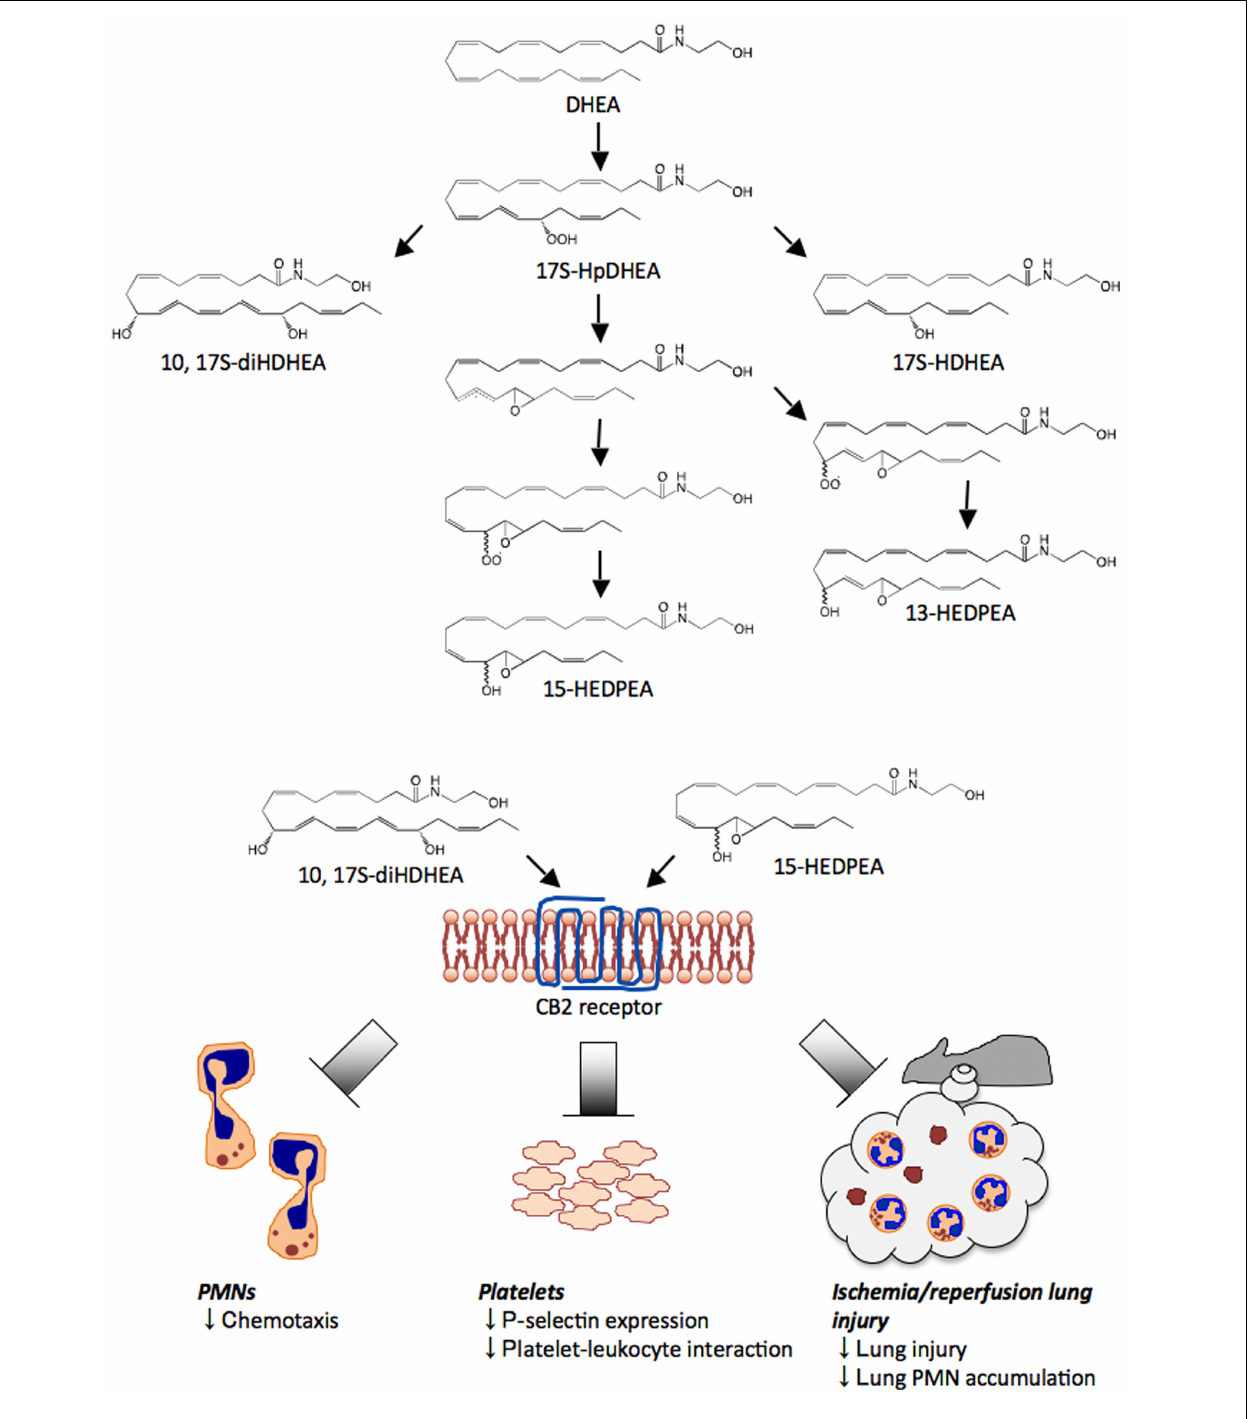
mechanism, 17-HpDHEA is converted to 10, 17S-diHDHEA or directly reduced to 17S-HDHEA. 10, 17S-diHDHEA, and 15-HEDPEA block PMN chemotaxis, reduce P-selectin expression and aggregation of platelets and leukocytes, and show organ protection in ischemia/reperfusion injury. Although these new products directly act on recombinant CB2 receptors in vitro , the activation of CB2 in vivo and/or additional receptors in vivo by 10,17 S -diHDHEA and 15-HEDPEA remains of